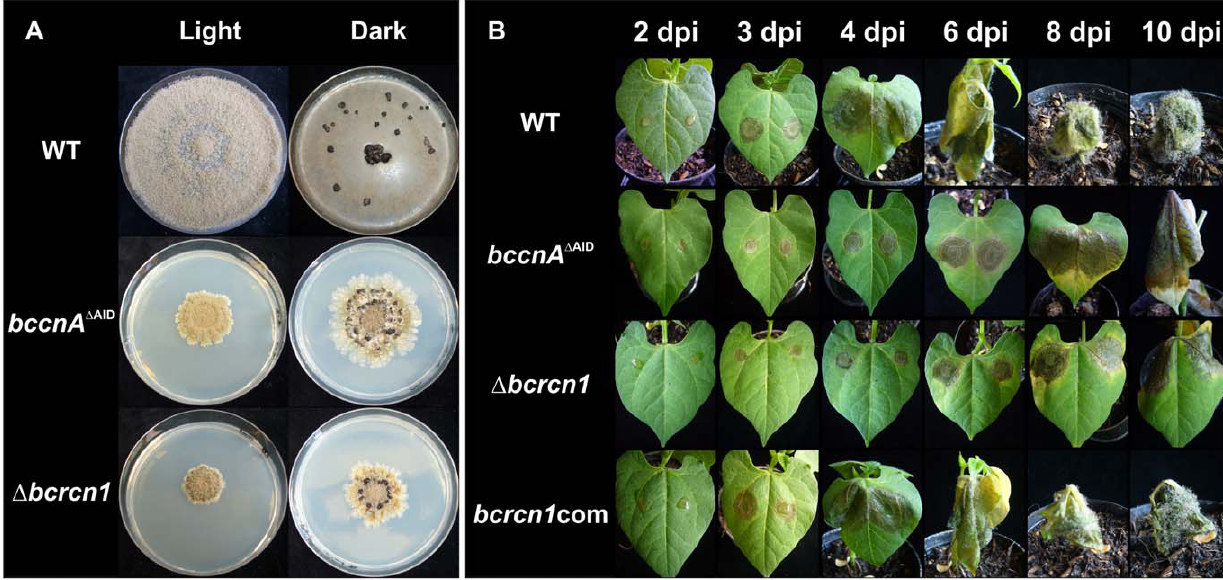
Figure 2. Phenotypical characterization of bccnA D AID and bcrcn1 mutants. Analyzed strains: B. cinerea wild-type B05.10 (WT), bccnA D AID mutant (expressing truncated version of bccnA ), D bcrcn1 mutant, D bcrcn1 complementation strain ( bcrcn1 com). A: Growth on complete medium (CM) after 2 weeks in light/dark (12 h/12 h) regime for conidiogenesis and darkness (sclerotia formation). B: Pathogenicity assay: living bean leaves were inoculated with spore suspensions (2*10 5 spores/ml). Pictures were taken 2–10 days post infection